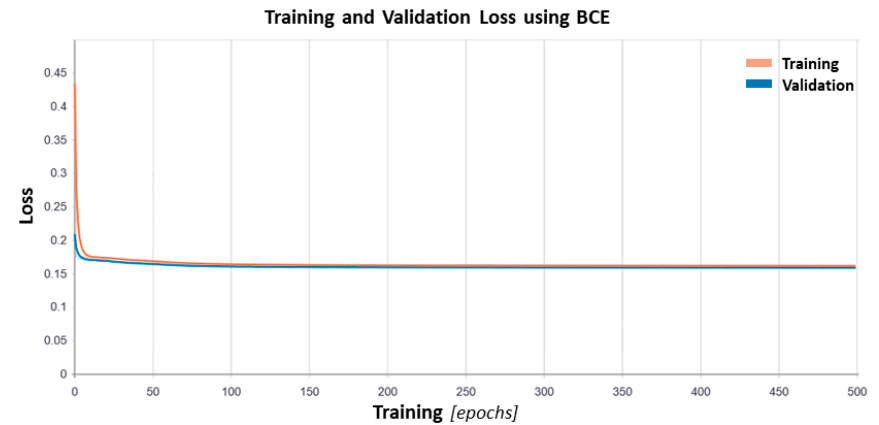
Figure 5. The binary cross entropy loss is presented for training and validation of the proposed sparse autoencoder for 300 epochs.